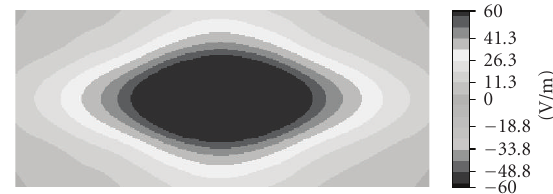
Figure 3: Field distribution inside the antenna.